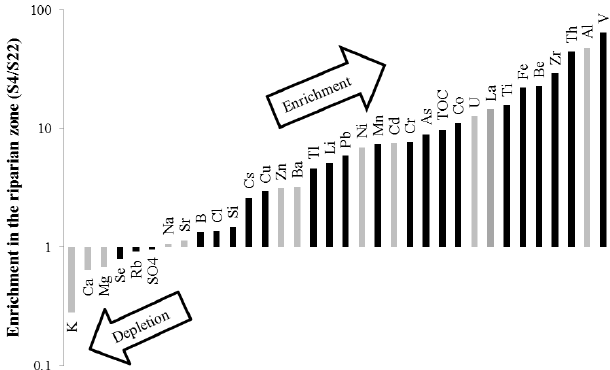
Figure 4. Relative enrichment in the riparian soil water and ground- water expressed as the ratio between the average concentration in the riparian profile (S4) and the average concentration of the ups- lope Podzol profile (S22). Elements marked in grey are included in the regression in Fig.